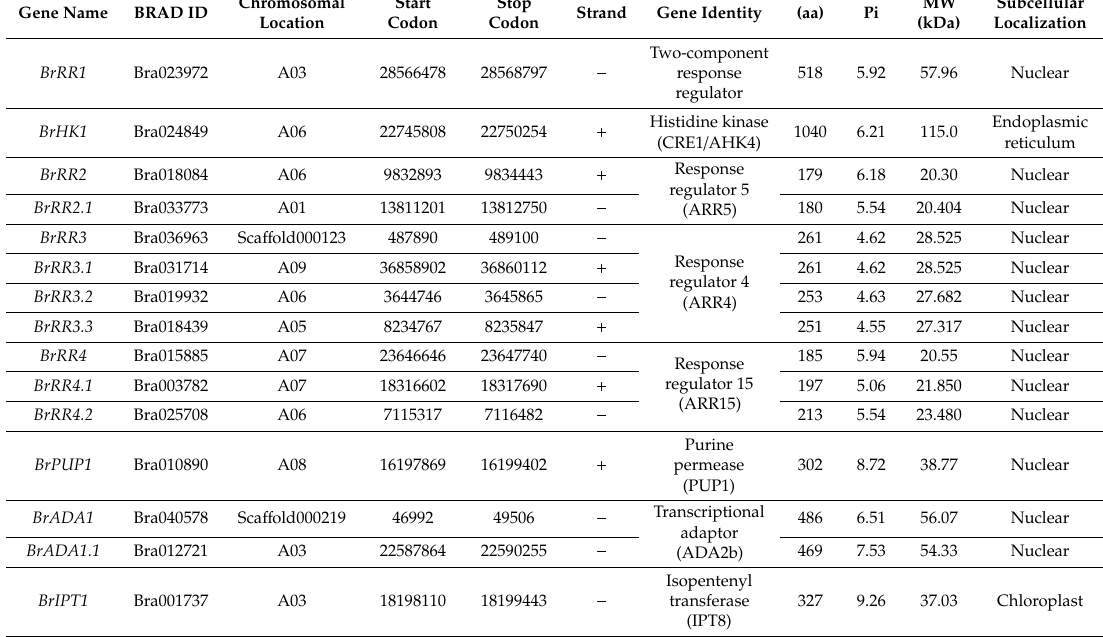
Table 1. Properties of genes involved in cytokinin metabolism, signaling, and transport in Brassica rapa. aa, amino acid; Pi, isoelectric point; MW, molecular weight; ER, endoplasmic reticulum. BrCRR1 is involved in protein phosphorylation and BrPYL1 is receptor of